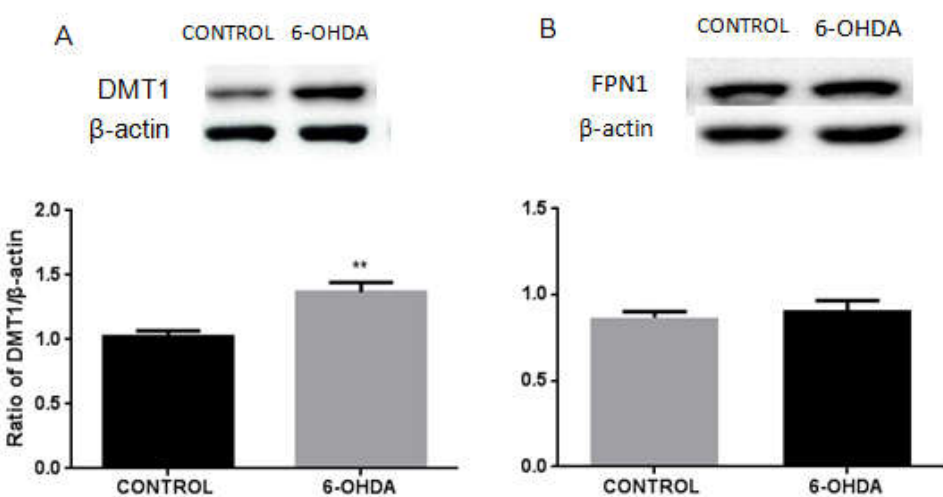
Figure 1. Protein levels of DMT1 and FPN1 in 6-OHDA-treated BV2 cells. ( A ) Western blot analysis to detect DMT1 protein levels. Increased expression of DMT1 was observed in 10 µ M of 6-OHDA treated-BV2 microglial cells. β -actin was used as the loading control. Data are presented as the ratio of DMT1 to β -actin levels. ( B ) Western blot analysis to detect FPN1 protein levels. The expression of FPN1 did not change in 10 µ M of 6-OHDA treated-BV2 microglial cells. β -actin was used as the loading control. Data are presented as the ratio of FPN1 to β -actin levels. Each bar represents the mean ± SEM from six independent experiments. n = 6. ** p < 0.01, p > 0.05, compared with the control group.